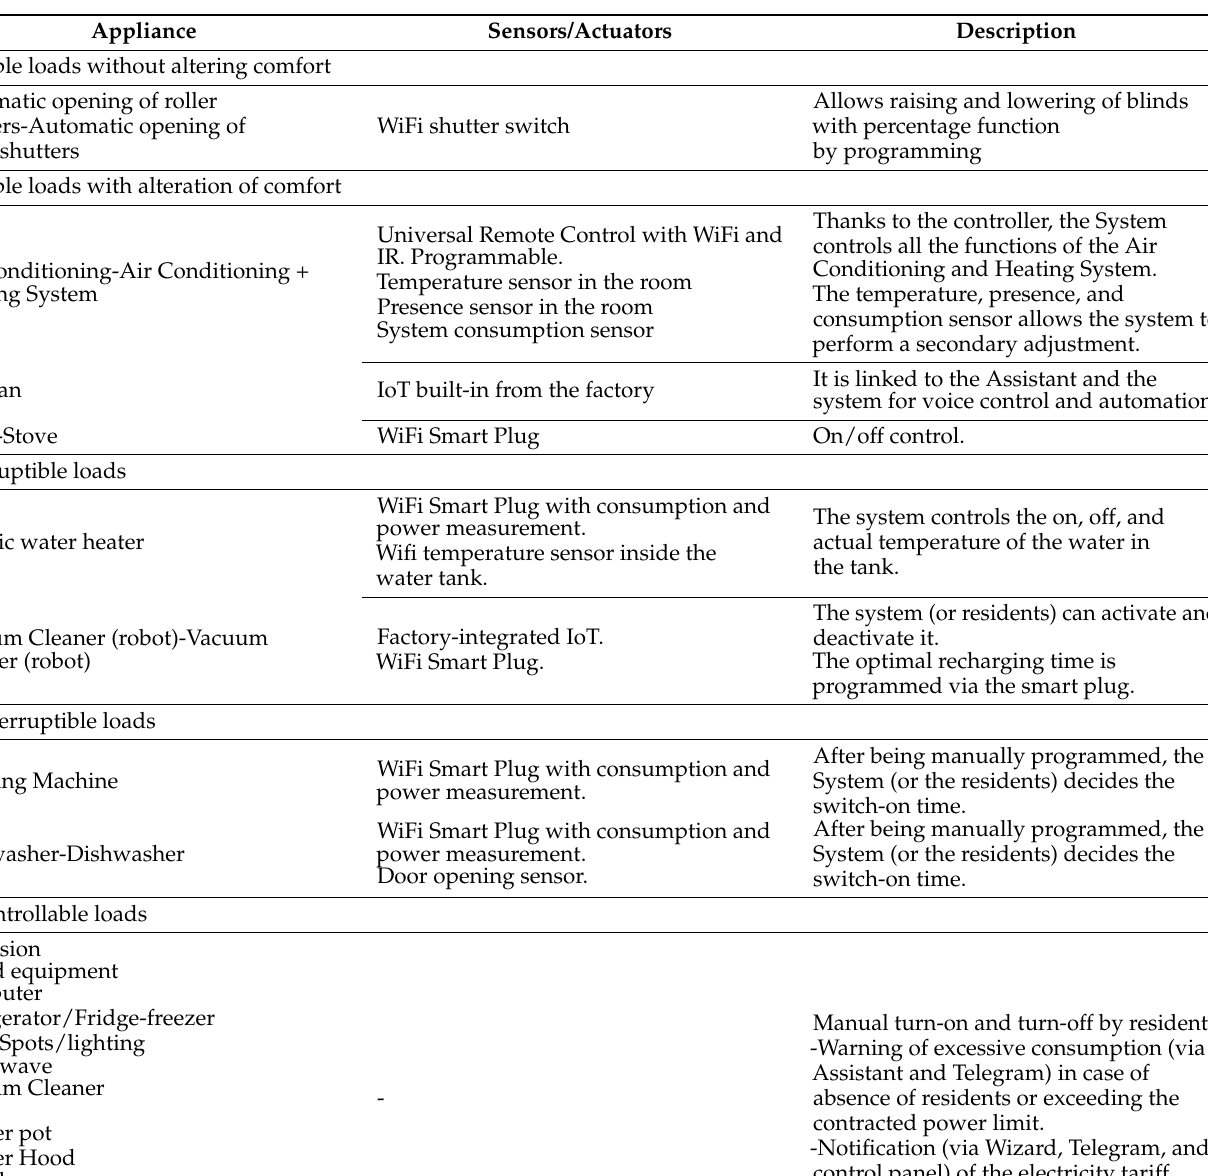
Table 3. IoT sensors and actuators in the main loads of the